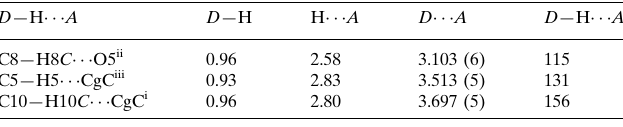
Hydrogen-bond geometry (A˚ , (cid:1)